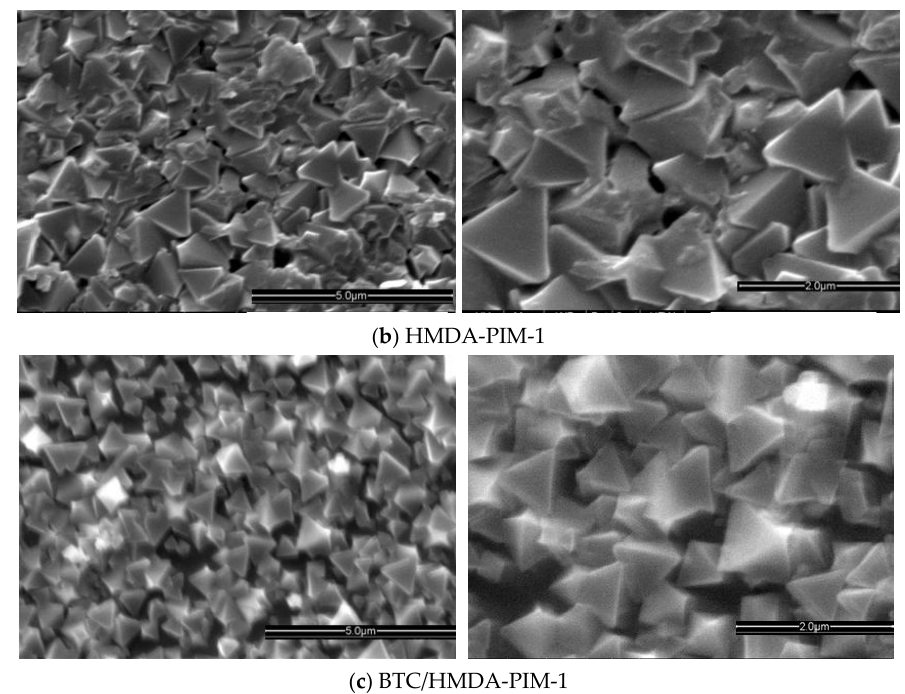
Figure 7. The XRD patterns of the HKUST-1 clearly reproduce the simulated pattern and confirm the formation of HKUST-1 (Figures S6 and S7 in the SI). The much sharper XRD patterns on the HMDA-PIM-1 than on the BTC/HMDA-PIM-1 membranes indicate the formation of larger and defect free crystals on the HMDA-PIM-1 supports. ATR-FTIR spectroscopy confirmed the presence of HKUST-1 on the surface of the HMDA-PIM-1 and BTC/HMDA-PIM-1 membranes, showing the typical signals of HKUST-1 at 700 cm −1 , 1380 cm −1 and 1620 cm −1 in the same range for the sandwich membranes (Figure S8 in the SI).